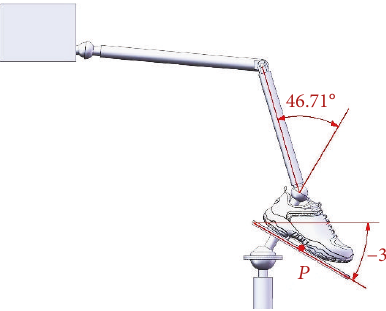
Figure 7: Limit posture of the ankle joint for the plantar fl exion motion ( α max = − 30 ° ).